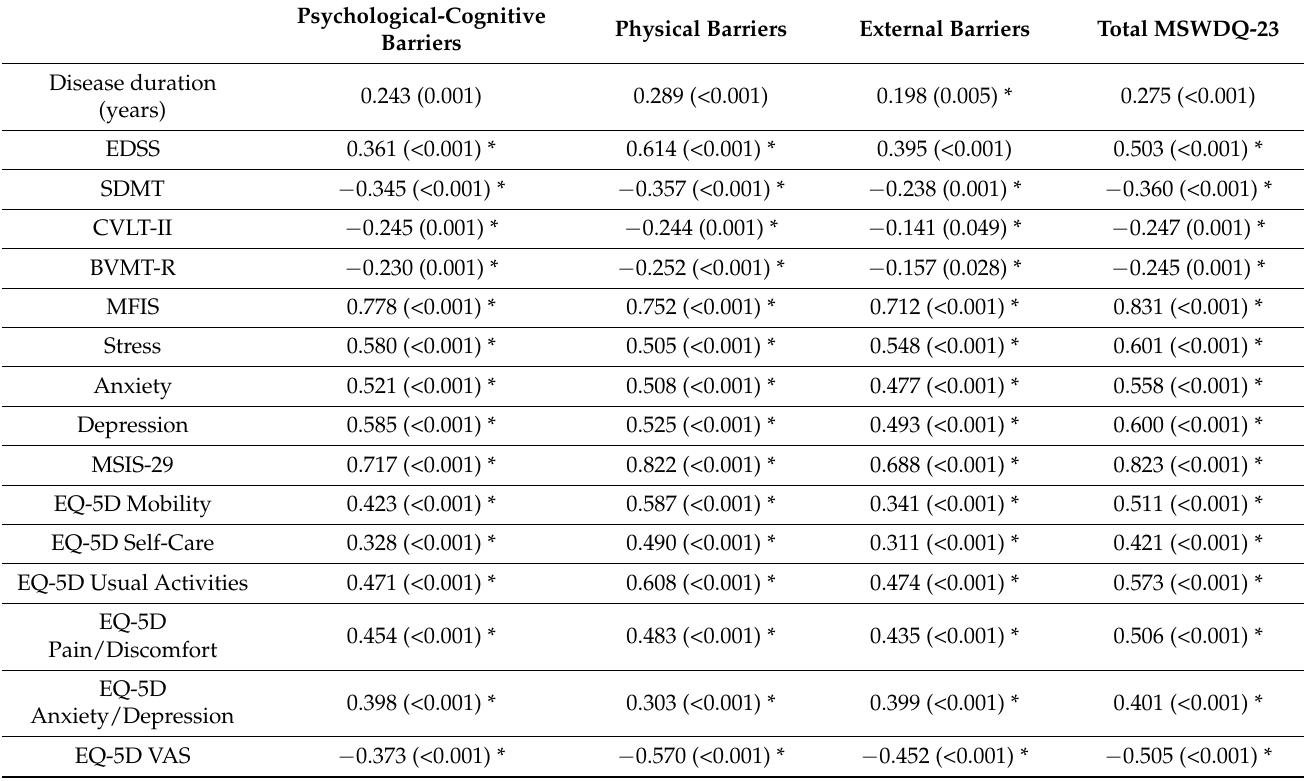
Table 4. Convergent validity of the MSWDQ-23. Pearson’s rho coefficients ( p